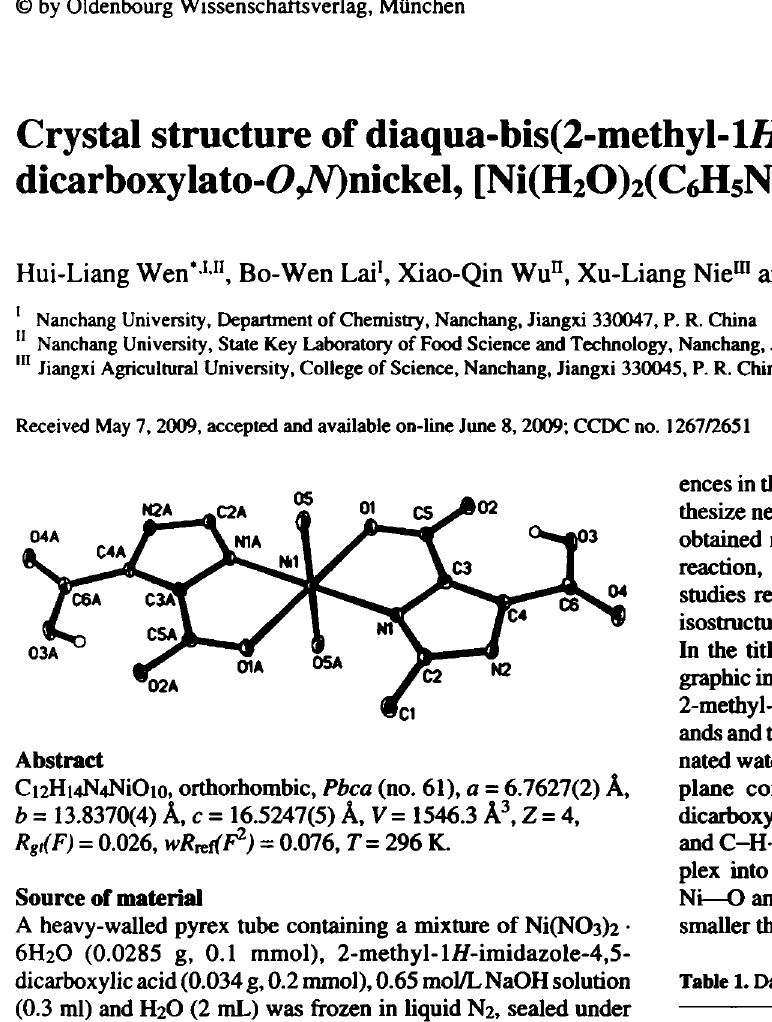
Table 1. Data collection and handling.